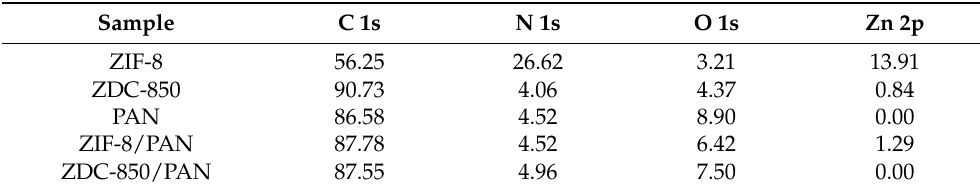
Table 1. The atomic ratios (at.%) of surface elements from the X-ray photoelectron spectroscopy (XPS) profiles.